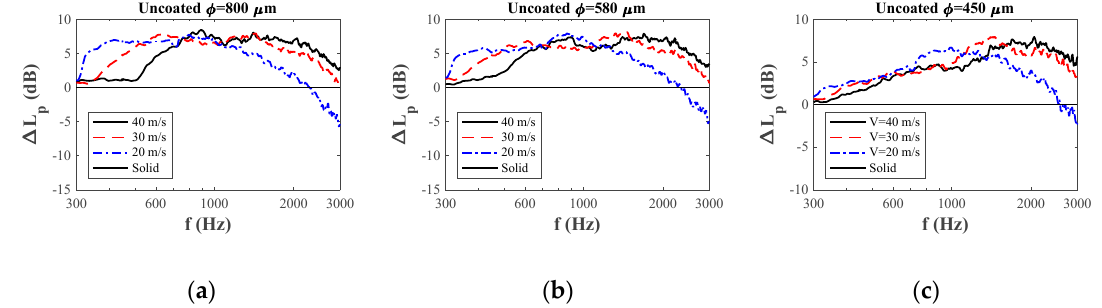
Figure 7. Comparison of noise abatement ∆ L p diagrams of uncoated trailing edges with ( a ) 800 µ m, ( b ) 580 µ m, and ( c ) 450 µ m pore size.